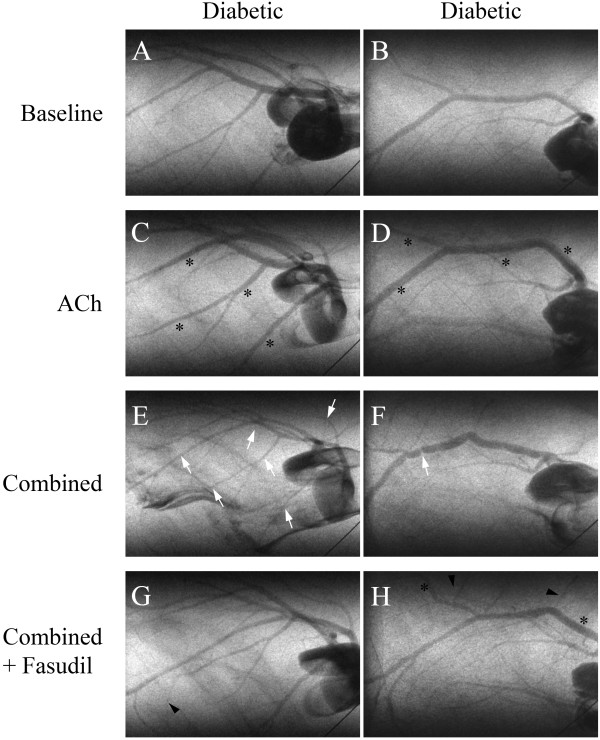
Additional synchrotron radiation angiograms of the coronary vasculature in two diabetic rats showing segmental constrictions. Baseline lactate infusion (A &B), ACh infusion (C &D; 3.0 μg/kg/min), following administration of L-NAME (10 mg/kg iv. bolus) and meclofenamate (combined, E &F; 2 mg/kg iv. bolus) and subsequent combined + fasudil treatment (G &H; 10 mg/kg iv). A &B, Baseline response to vehicle infusion. C &D, Both diabetics maintained larger vessel ID than baseline (black asterisks). E &F, Diabetic focal and segmental vasoconstrictions (white arrows). G &H, Restoration of medium and small arteries to baseline ID, dilation (black asterisks) and recruitment of newly visualised small arteries and arterioles relative to baseline (arrowheads). ‘w’ is a 50 μm tungsten wire for vessel ID determination.